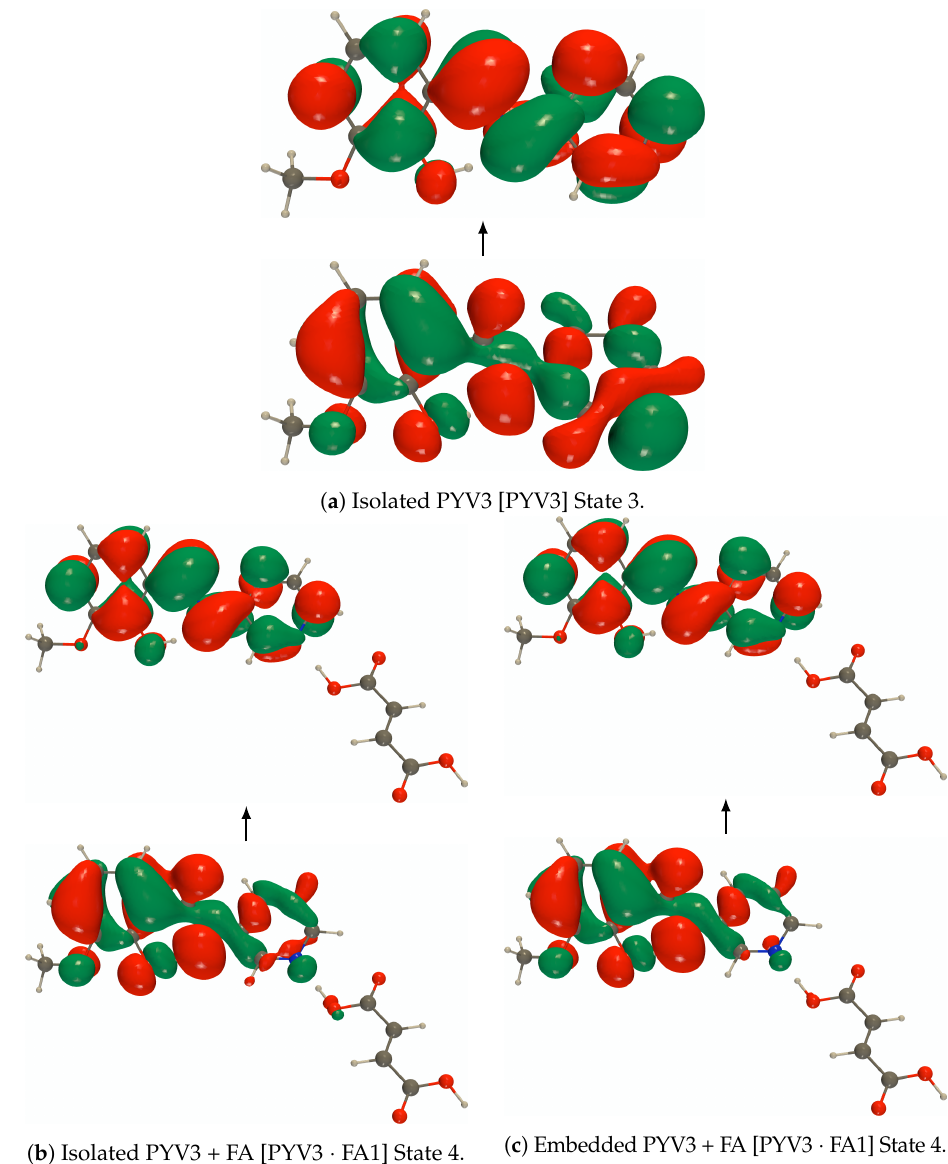
Figure A4. RI-CC2/def2-TZVPD NTOs (holes below the arrows and particles above them, the red (green) lobes are the positive (negative) ones) of the 3rd excited state of the isolated PYV3 [PYV3] enol form and of the 4th excited state of the isolated and embedded PYV3 + FA [PYV3 · FA1] (isovalue of